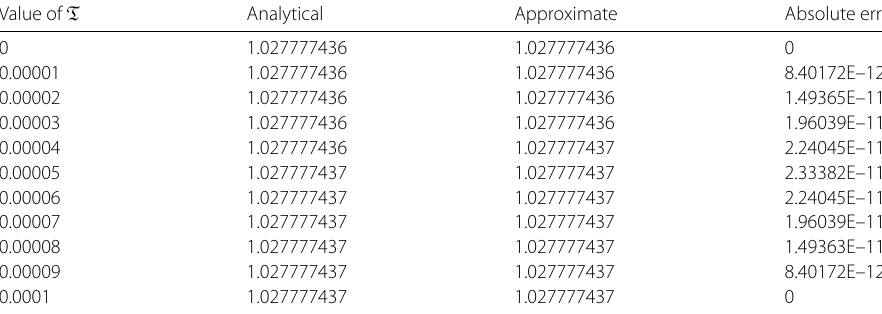
Table 3 Numerical values of the solutions through the CBS method Value of T Analytical Approximate Absolute error 0